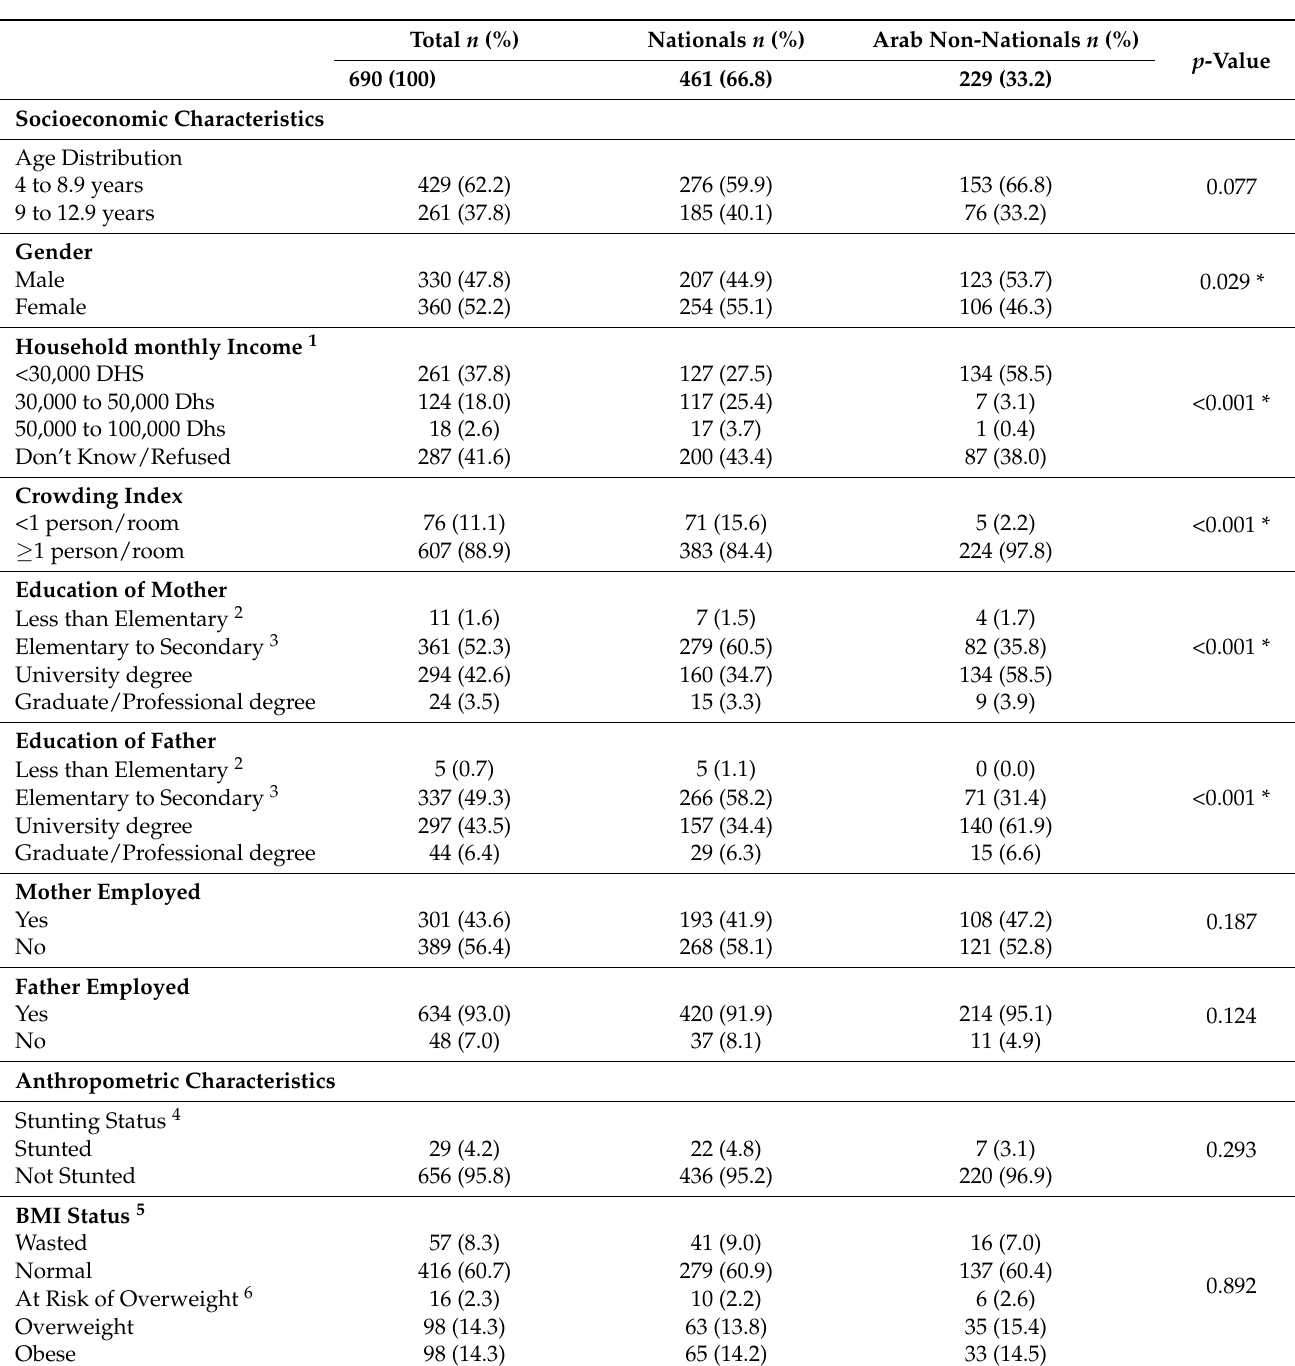
Table 1. Sociodemographic and Anthropometric Characteristics of UAE Children Aged 4–12.9 years, KNHS